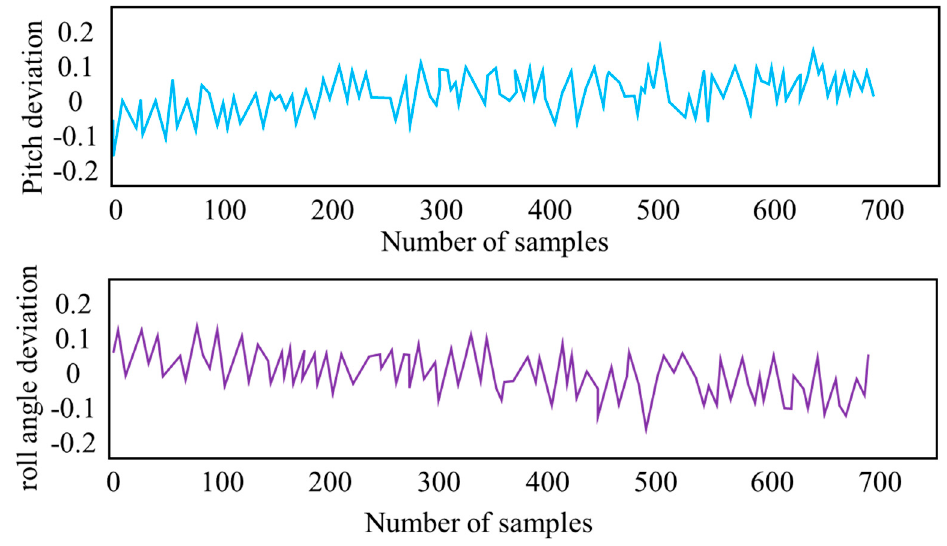
Figure 6. The end pose measurement of the bionic robot.